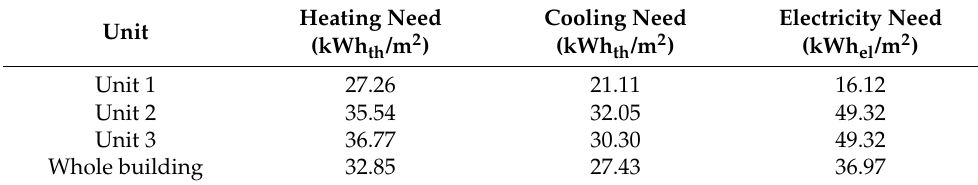
Table 8. Specific heating, cooling and electricity needs of the three